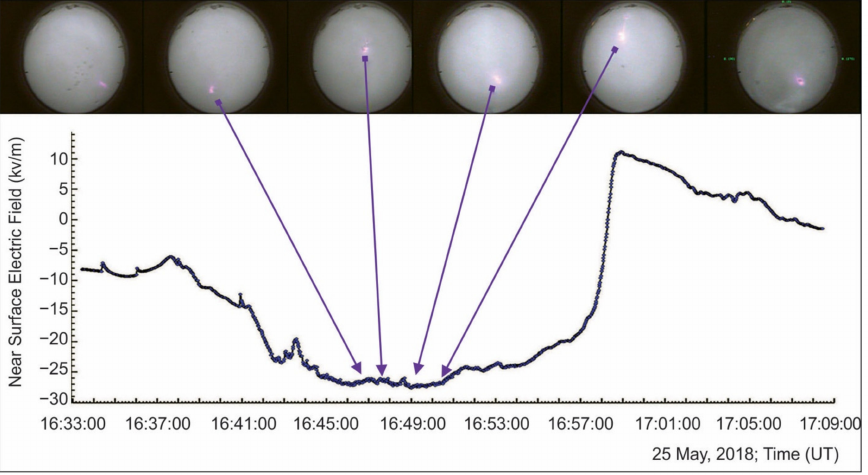
Figure 13. The disturbances of the NSEF during TGE, measured by EFM 100 electric mill located on the roof of MAKET experimental hall. In the upper panel we portray the panoramic camera shots of the sky above the station; with violet arrows, we indicate the times when panoramic shots were done.